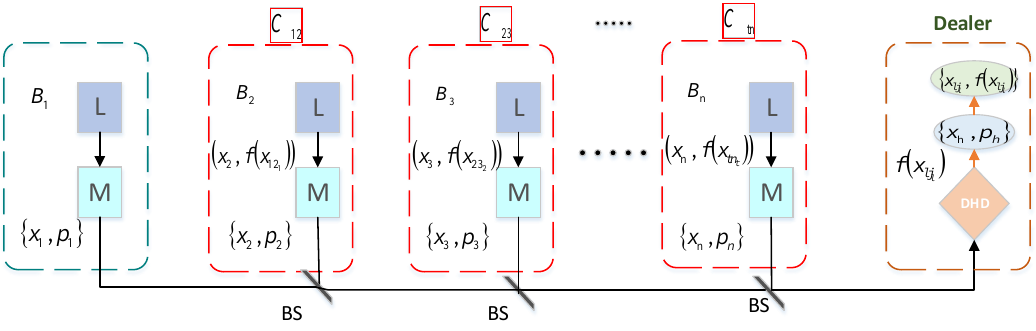
Figure 2. The data-processing of legitimate t participants and the dealer. L is laser, M represents modulator, BS is beam splitter, DHD expresses double homodyne detector, { x j , p j } are independent Gaussian random numbers retained by participant B j , { x j , f ( x lj { 1,2, · · · , t } , j ∈ { 1,2,3, · · · , n }